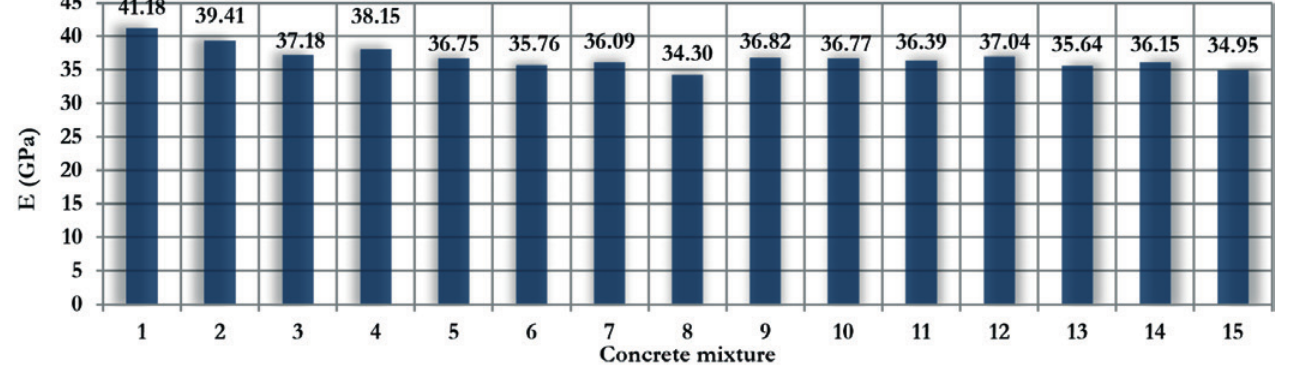
Elasticity modulus test results for each concrete